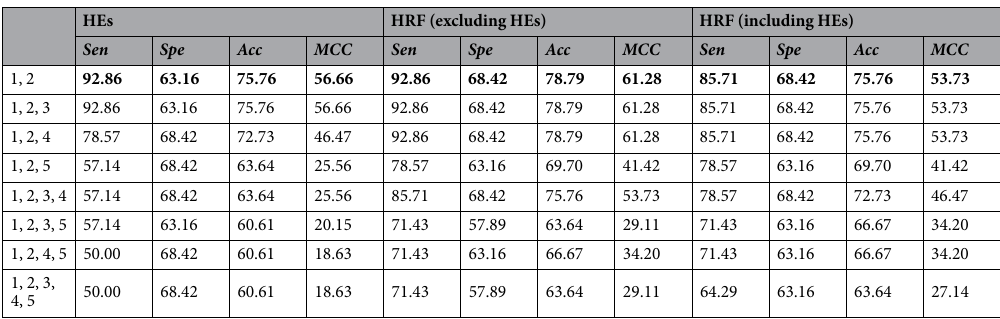
Table 1. Results of evaluation indexes under different feature combinations based on HEs, HRF (excluding HEs) and HRF, Unit: %. * No. 1–5 represent average area, average amount, average distance, average altitude and average reflectivity, respectively.